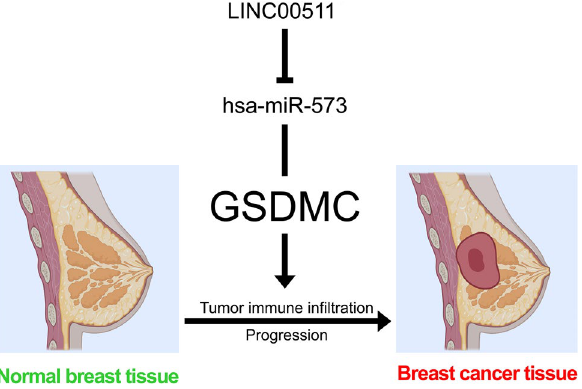
Figure 15. The model of LINC00511/GSDMC/hsa-miR-573 axis in carcinogenesis of